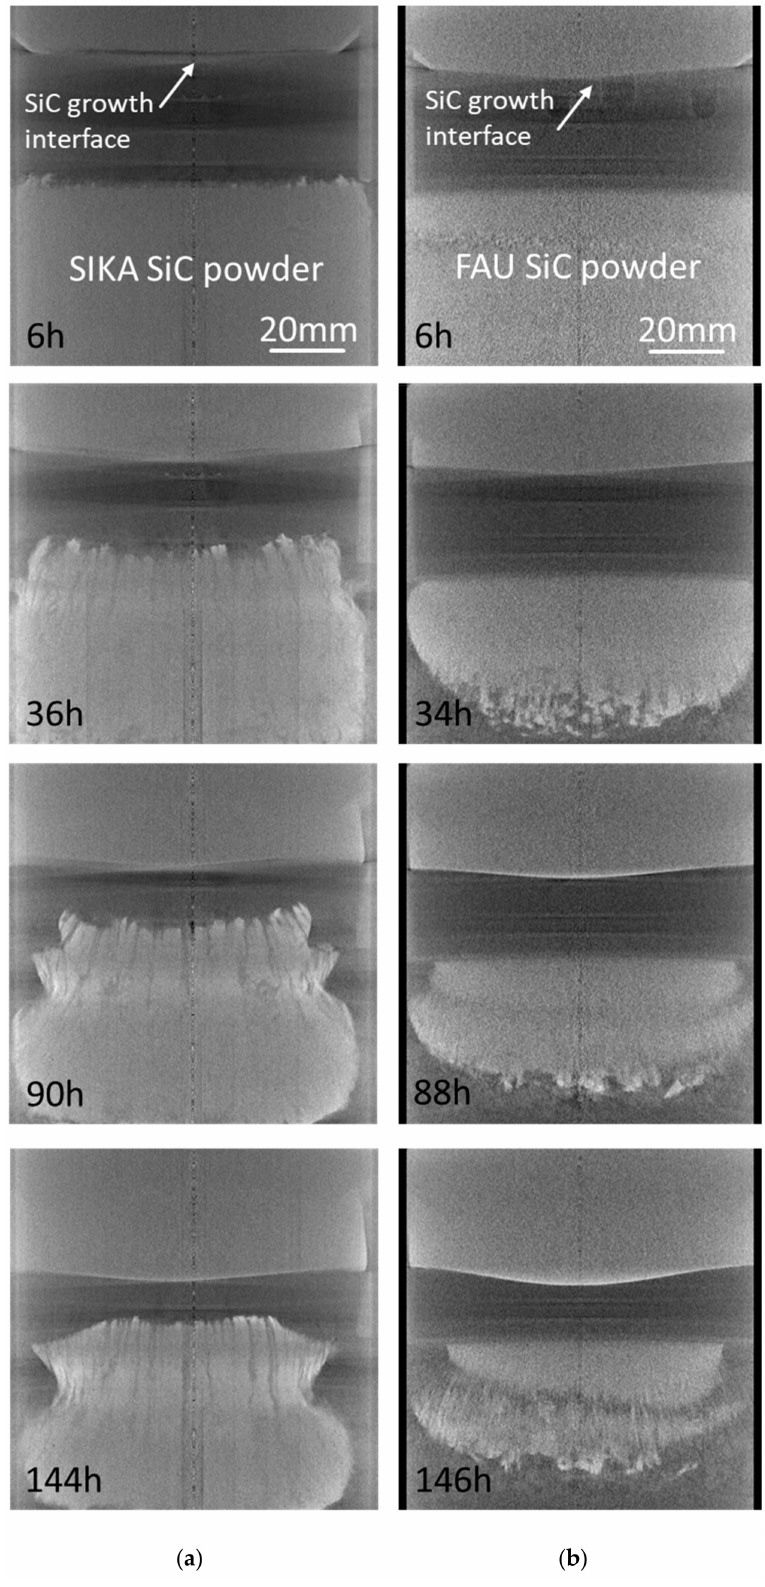
Figure 3. Series of 2D projections of the 3D in situ X-ray-based computed tomography visualization of the growth process of the 75 mm PVT growth process: ( a ) SiC powder from SIKA and ( b ) reference SiC powder from